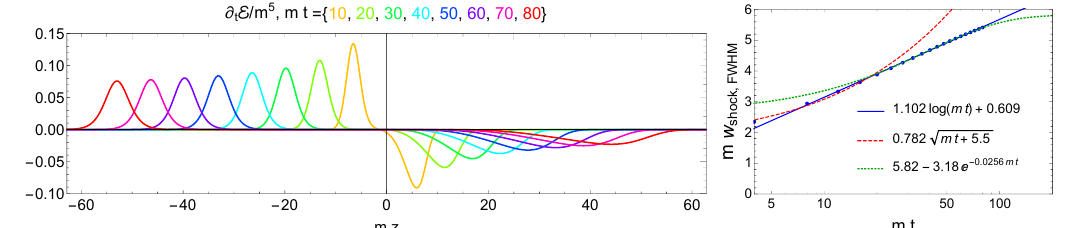
Figure 13: We show the change in shape of the outgoing waves from the time deriva- tive of the energy density. Colours from yellow to red correspond to snapshots of the energy density profile from early to late times. Both, the left moving and the right moving waves disperse. On the right we show the time evolution of the full-width at half-maximum together with different numerical fits, corresponding to diffusive growth (red dashed), logarithmic growth (blue solid), or a possible exponential de- cay to a shock of constant width at late times (green